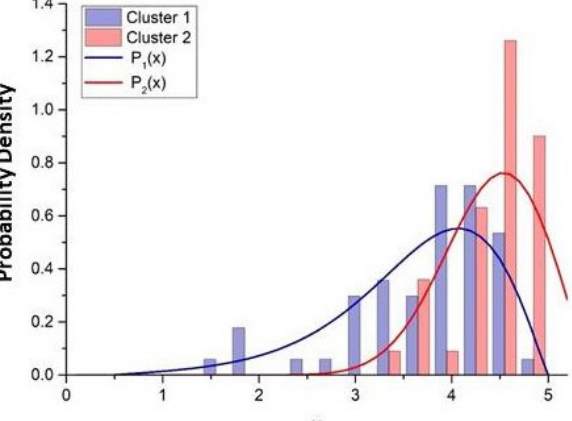
Figure 4. Distribution functions P 1 ( x ) and P 2 ( x ) vs. x , for Clusters 1 and 2 [83–86]. Here, ( T ) is the non-acoustic index, with T x = log T T representing the mean daily traffic flow of the 10 given road stretch. The clusters C 1 and C 2 correspond to those obtained from the analysis of traffic noise displayed in Figure